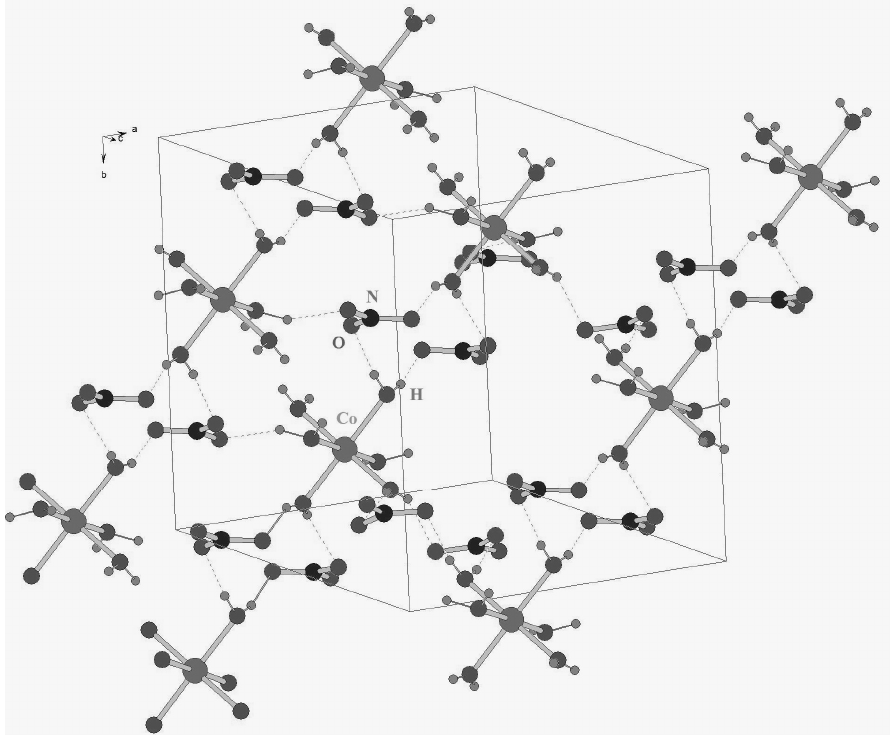
Figure 3. The layer of Co(H